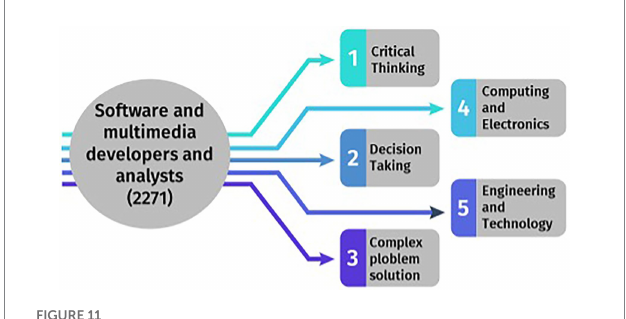
FIGURE 11 Some skills and competencies related with SINCO#2271. Own elaboration based on SINCO classification